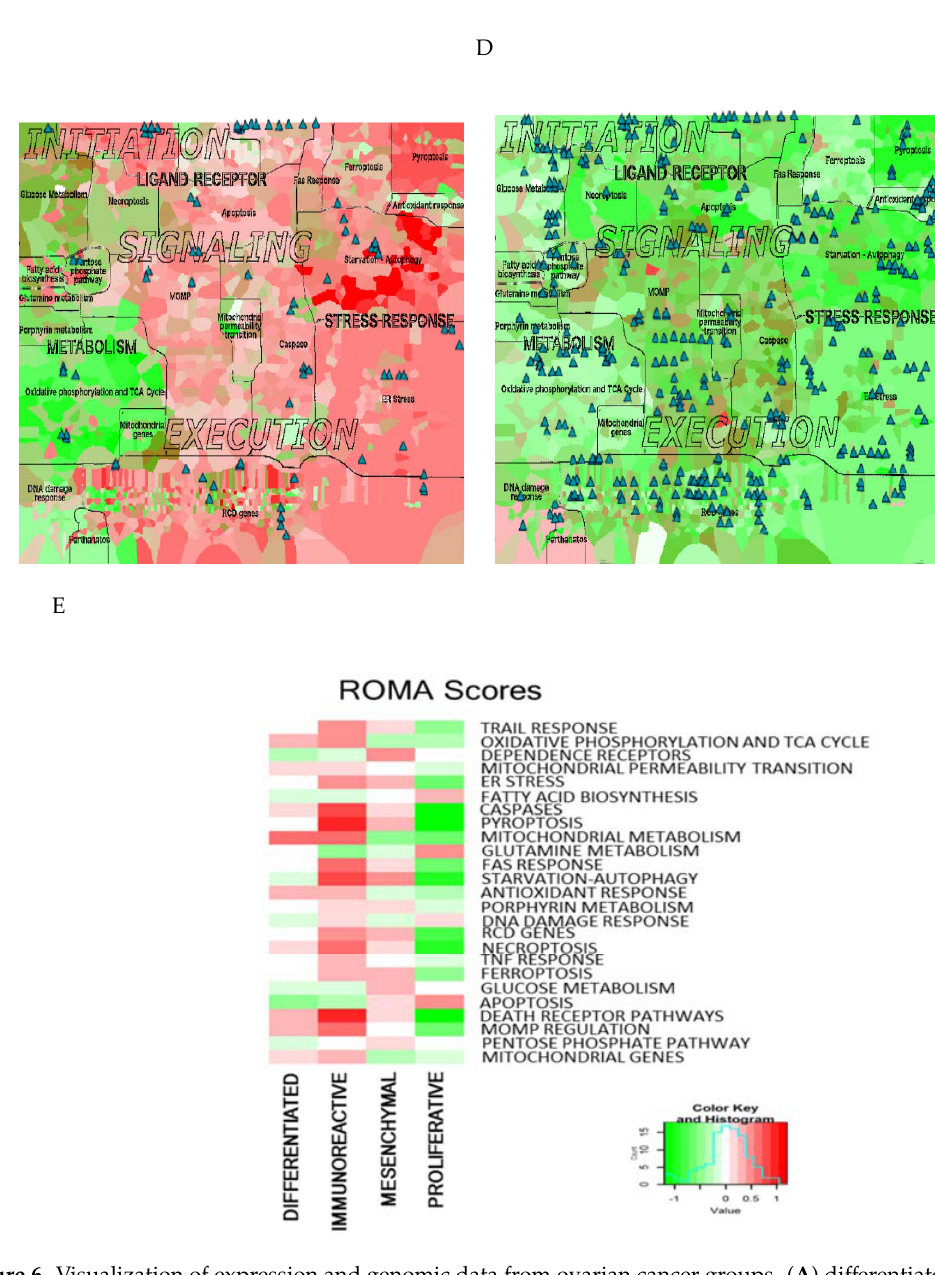
Figure 6. Visualization of expression and genomic data from ovarian cancer groups. ( A ) di ff erentiated, ( B ) mesenchymal, ( C ) immunoreactive, ( D ) proliferative subtype. The background color represents the expression value per protein (red: up-regulated, green: down-regulated). The glyphs (triangles) represent gene copy number gains above 4 copies. ( E ) Heat map of the ROMA scores per subtype.